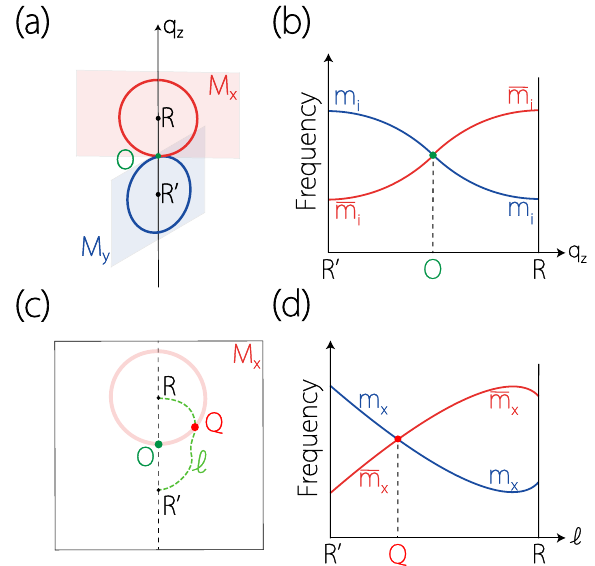
Fig. 2 Schematic diagram for a nodal chain. a Schematic diagram for a nodal chain formed by two rings located in two mutually orthogonal mirror planes M x and M y . O is a non-TRIM point with D 2d little co-group. b Spectrum along the q z axis for a pair of phonon branches that correspond to the E representation of D 2d at O . m i ( i = x , y ) are the mirror eigenvalues. c An arbitrary path ℓ in the M x plane, which connects a point R on the q z axis to its S 4 z image R 0 . The spectrum along ℓ is shown in ( d ), where the two branches must still cross at some point Q , as they have opposite m x eigenvalues. The crossing point traces out a ring in the M x plane, as shown in ( c